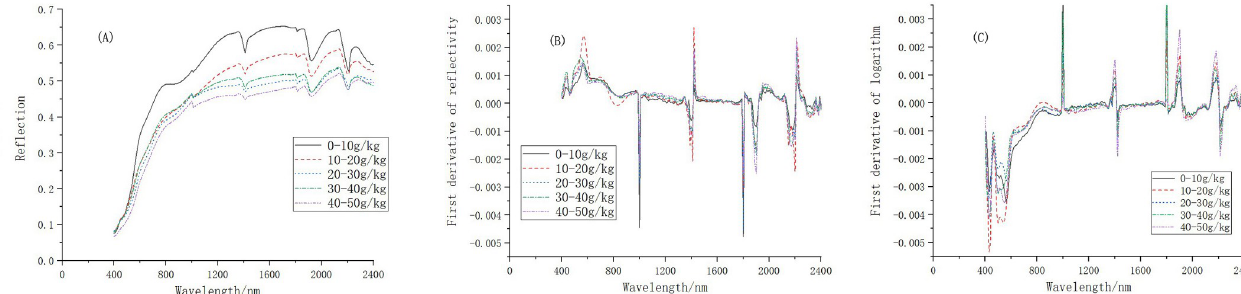
Fig 3. Average spectral curve of: (A) soil reflectance; (B) the first derivative; and (C) the logarithmic first derivative with different levels of organic matter content.